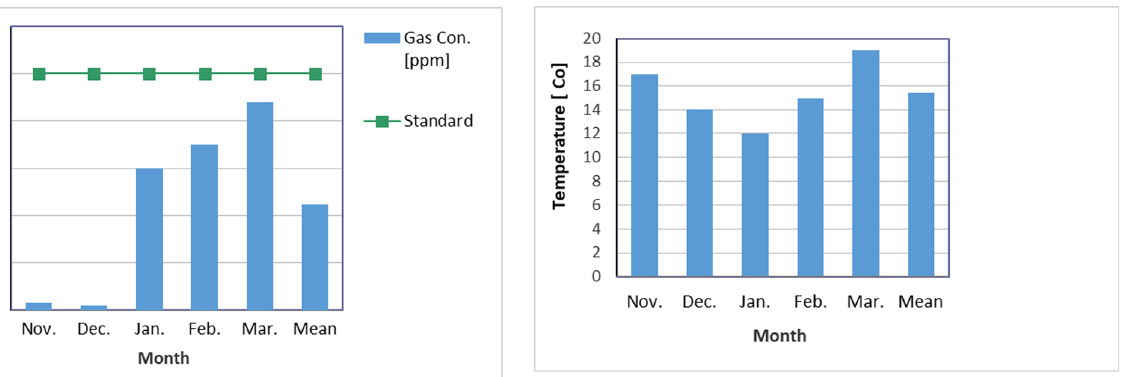
Figure 9: Monthly concentrations and overall mean of hydrogen sul fi de gas during the study period.